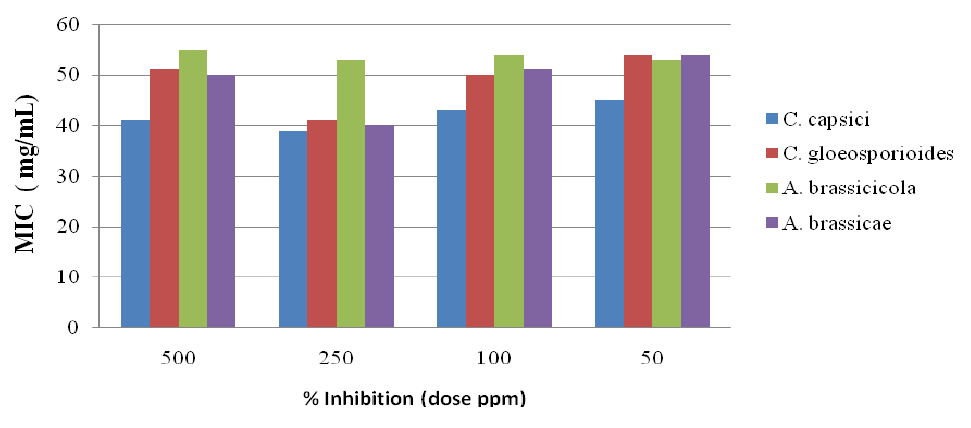
Positive control: fluconazole; negative control: